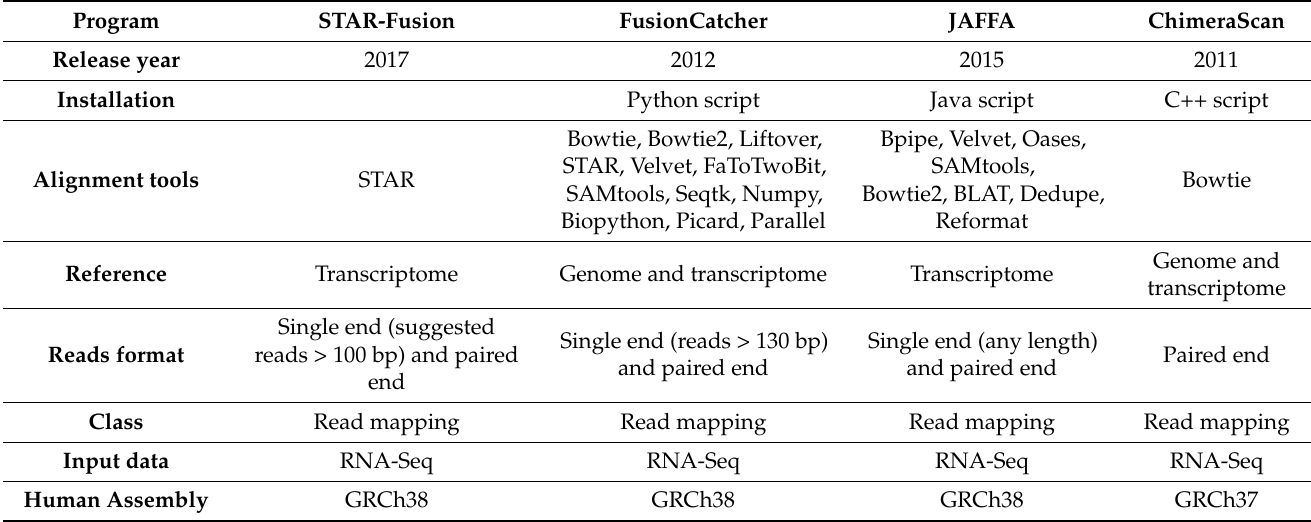
Table 3. Fusion detection